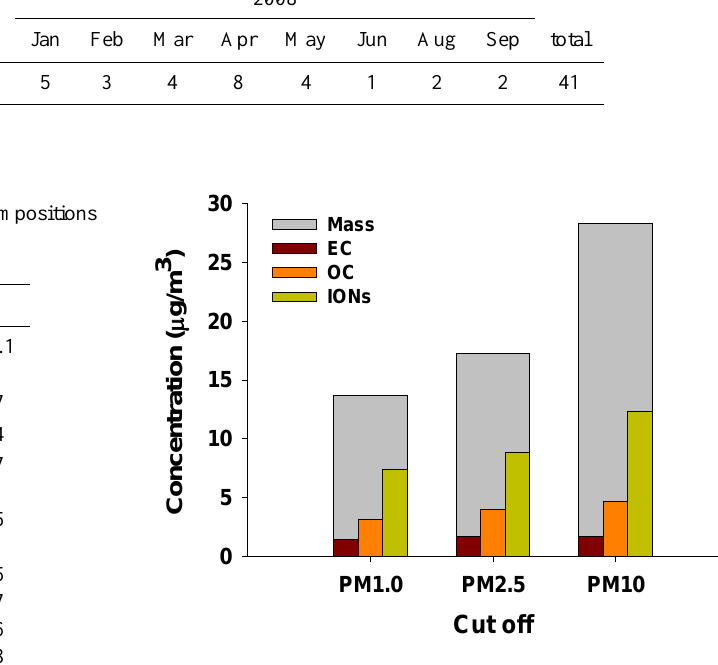
, K + , Na + , Ca 2 + , and Mg 2 + for 4